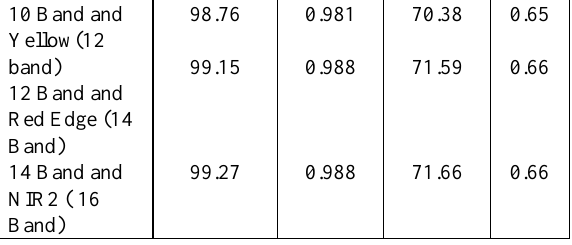
Table 5. Supervised classification of Hyperion data